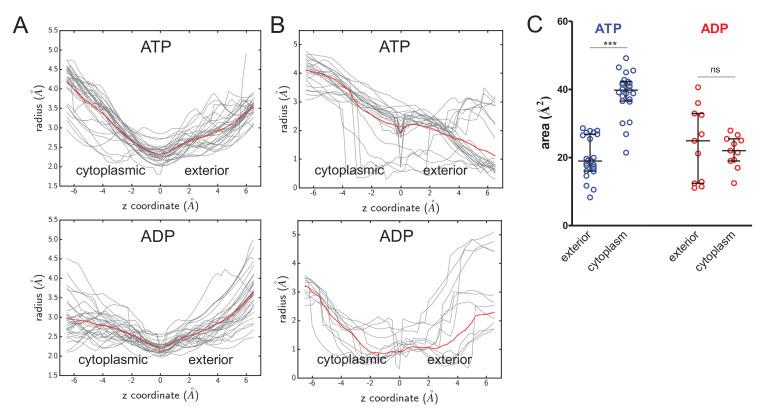
Cavity size analyses.(A) Quantified cavity sizes (i.e.cavity radius in Å) from the ATP- and ADP-bound SecA-SecYE-PP simulations along the z-axis of the SecY channel. Used for secondary analysis in Figure 4B. All traces are shown in grey, with a running average plotted in red. (B) As panel A, but for simulation data of ATP and ADP bound SecA-SecYEG complexes without pre-protein, where models were built based on PDB 3DIN (Zimmer et al., 2008), and simulated as described previously (Allen et al., 2016). (C) Secondary analysis of the data from panel B. Plotted are the median and interquartile range. The difference between the exterior and cytoplasmic cavities was tested against an unpaired two-tailed t-test, reporting p values of < 0.0001 and 0.5672 for ATP and ADP, respectively.